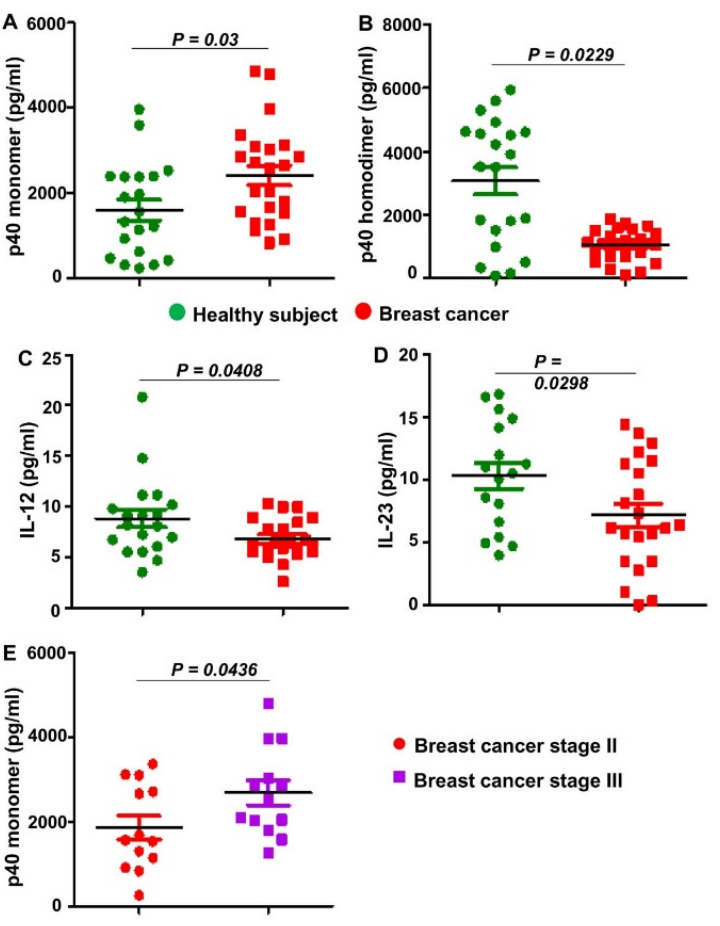
Figure 1. Levels of IL-12 family of cytokines in serum of breast cancer patients. Serum of drug-naïve breast cancer patients ( n = 23) and age-matched healthy controls ( n = 21) obtained from Discovery Life Sciences (Los Osos, CA) were analyzed for p40 ( A ), p40 2 ( B ), IL-12 ( C ), and IL-23 ( D ) by sandwich ELISA. Serum of stage II and stage III breast cancer patients ( n = 13) were also analyzed for p40 ( E ). Results were statistically analyzed by Student’s t ‐ test.